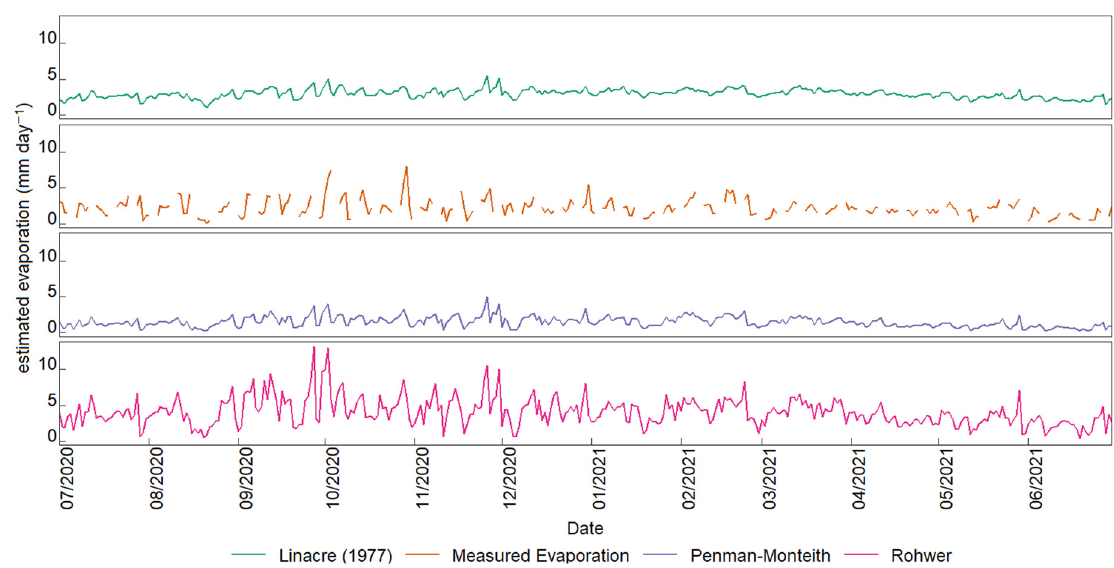
Figure 5. Comparison between estimated evaporation (mm day − 1 ) methods from Linacre (1977), FAO Penman-Monteith, Rohwer and the Measured Evaporation.